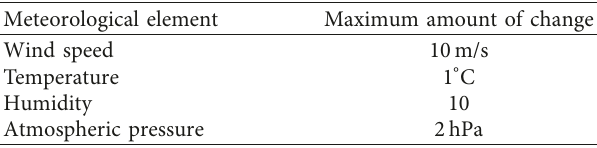
Table 3: Maximum amount of change for step test.